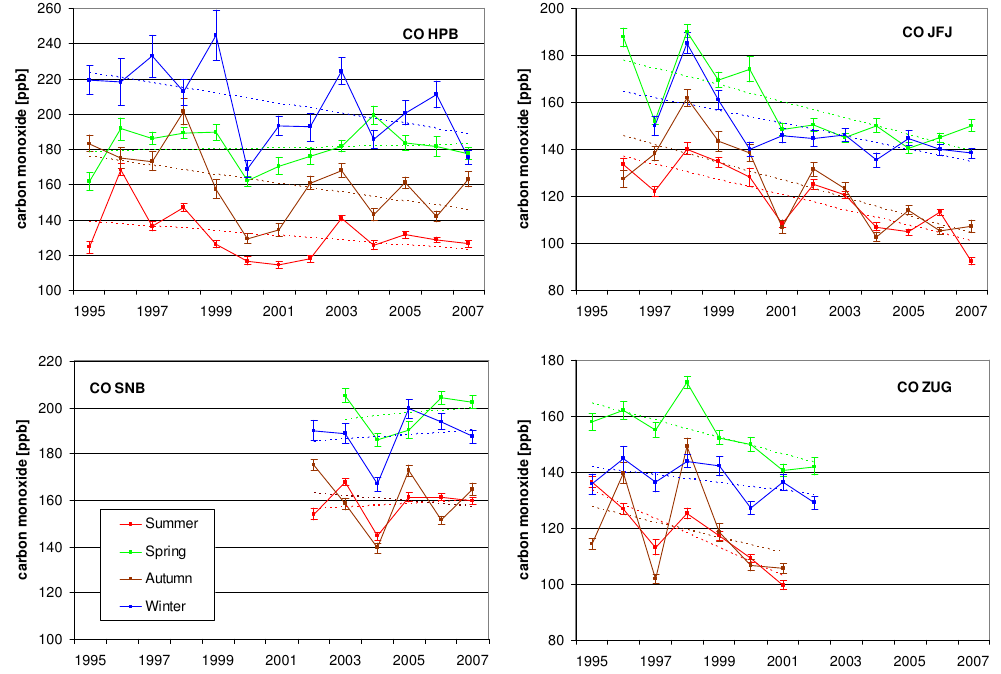
Fig. 10. CO time series since 1995 for the different seasons at the respective “DACH” sites; blue: winter; red: summer, brown: autumn, green: spring, yearly mean mixing ratios (solid) with standard error of the mean and linear trend (dashed).